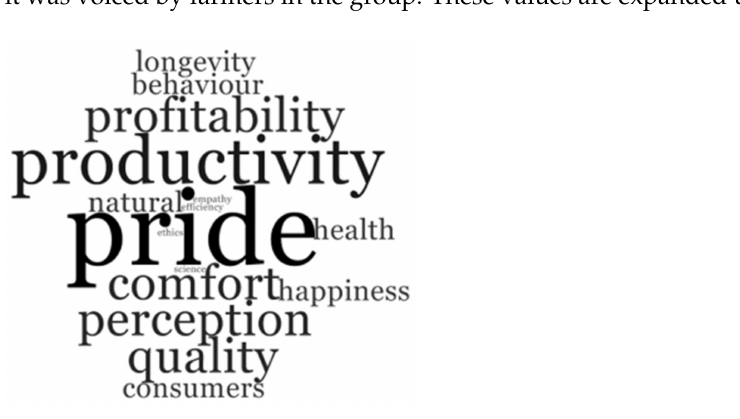
Figure 1. Word cloud representing farmer focus group values of positive